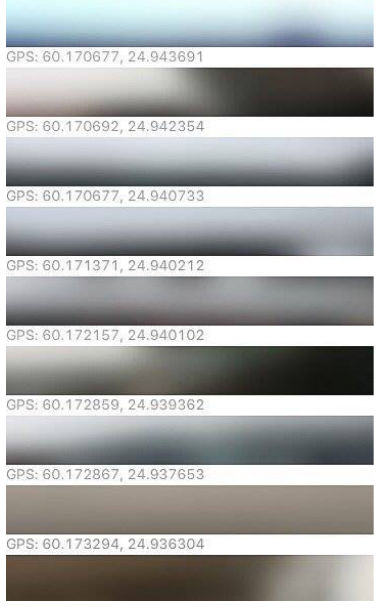
Fig. 12. Flowchart